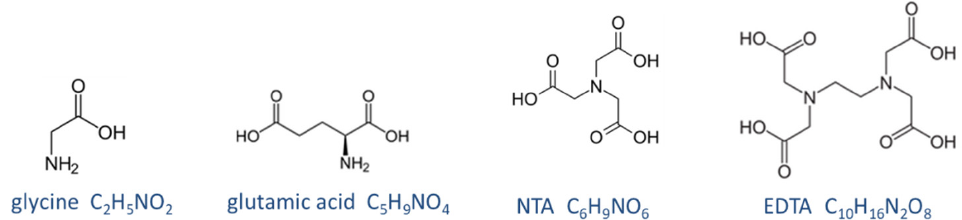
Figure 36. Structural formula of four zwitterionic acids.